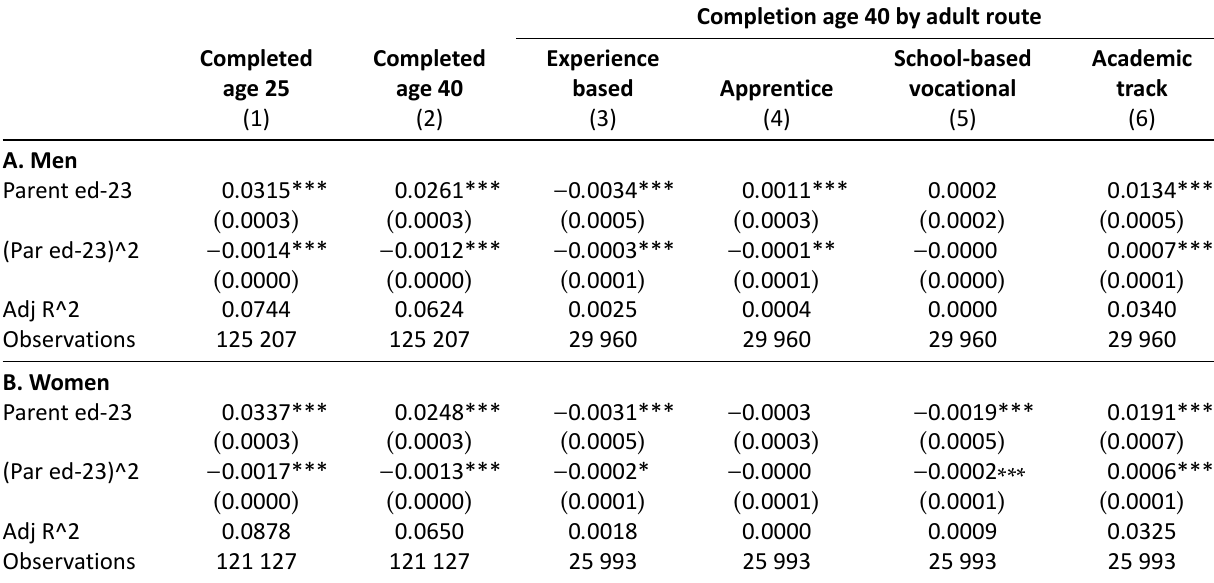
Table A2. Completion of upper secondary education; quadratic specification of parental years of